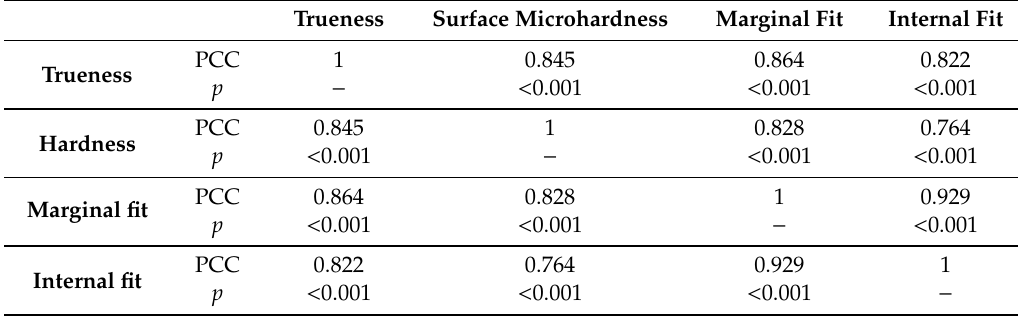
Table 6. Pearson correlation coe ffi cient (PCC) values for trueness, surface microhardness, marginal fit, and internal